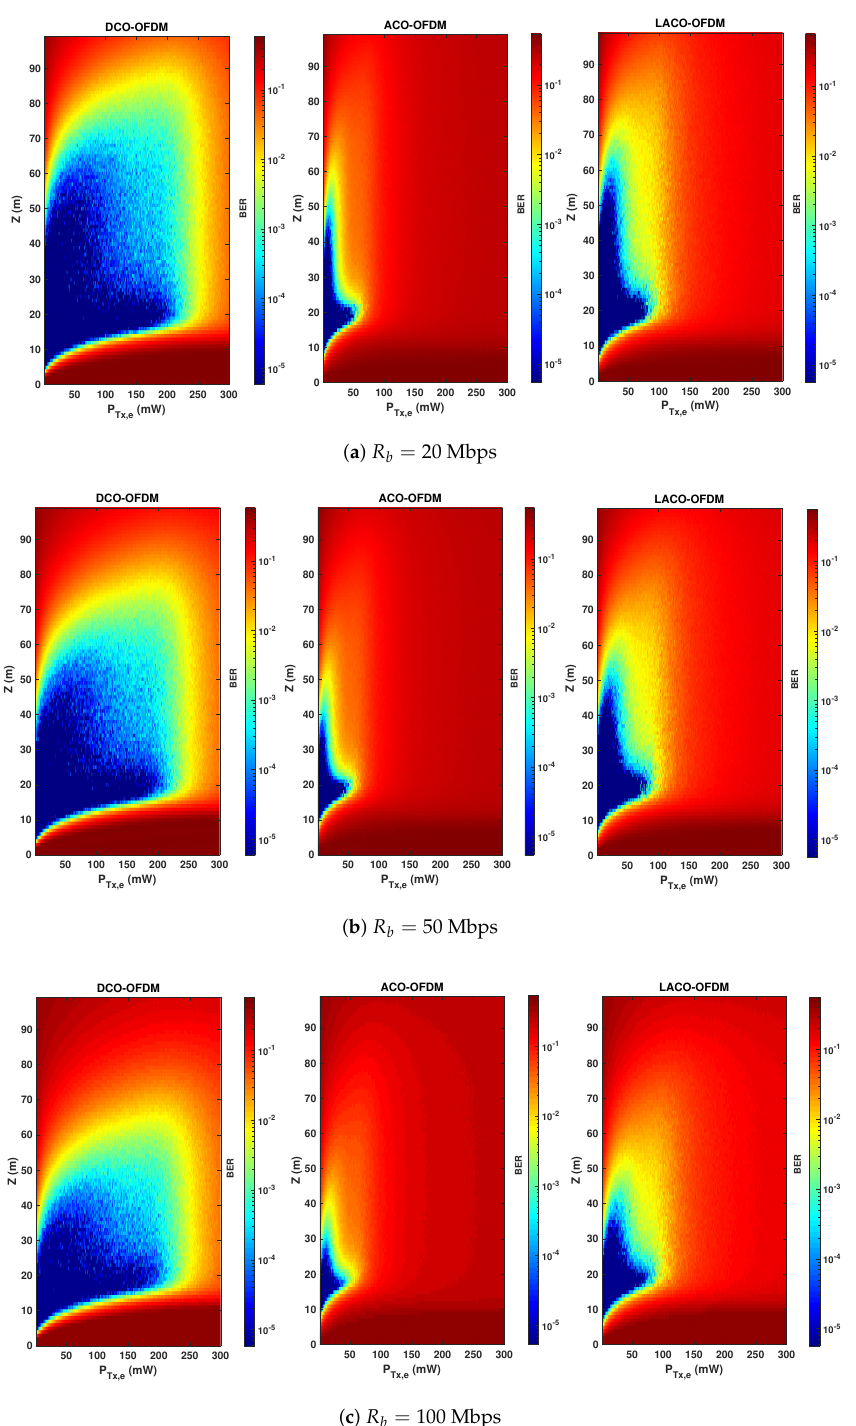
Figure 11. Comparison of BER versus the link range Z and the transmit electrical power P Tx,e of the three transmission schemes. N = 1024, N CP = 5, 11, and 20, for data rates of ( a ) 20, ( b ) 50, and ( c ) 100Mbps, η ≈